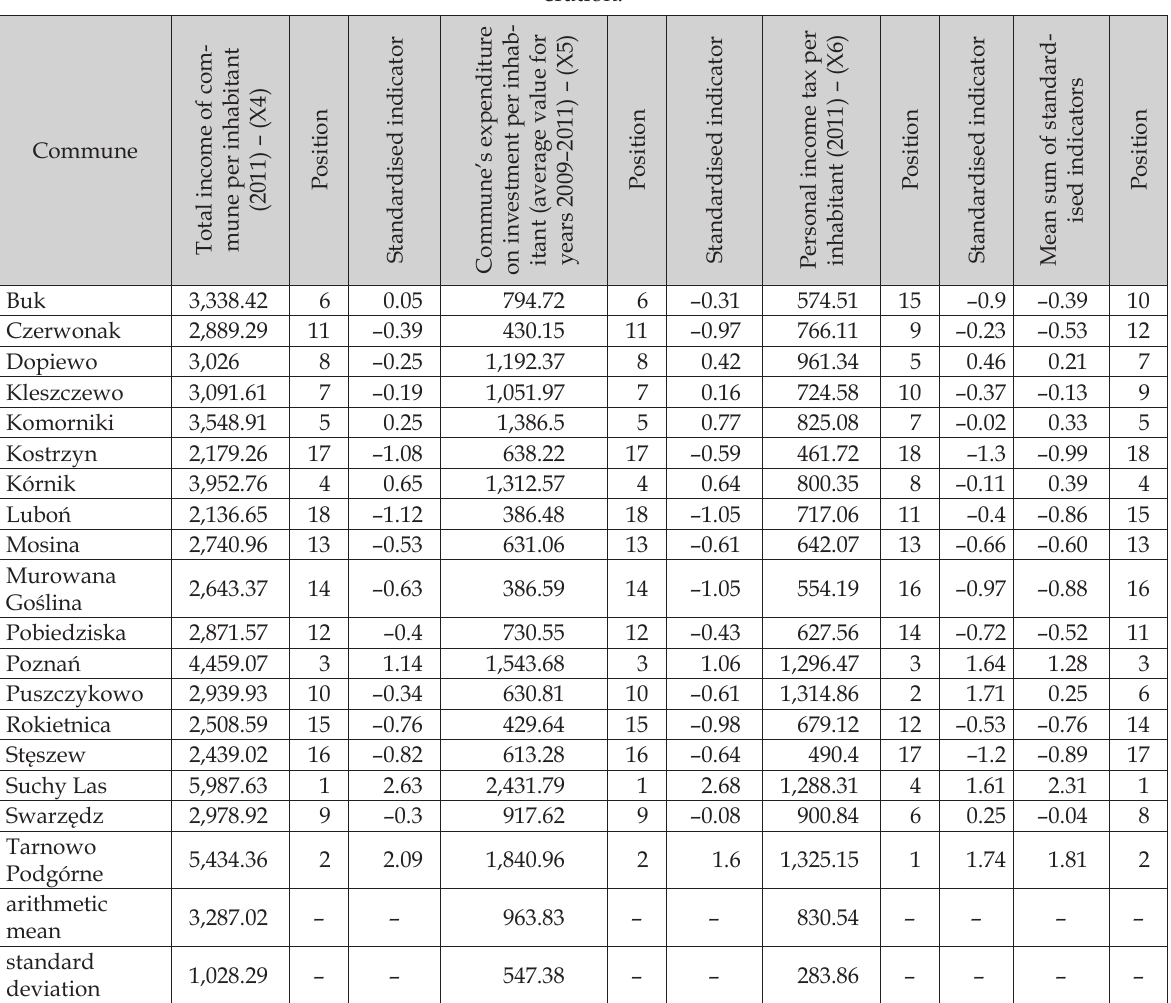
Table 2. Differences in the economic determinants of the quality of life in the communes of the Poznań agglom -